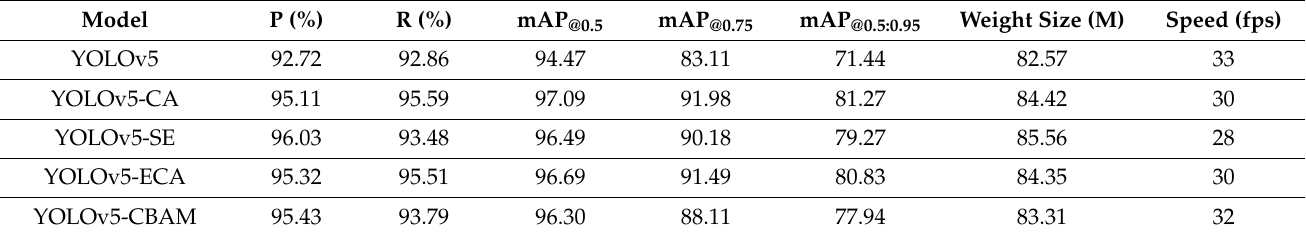
Table 3. Results of integrating different attention modules.